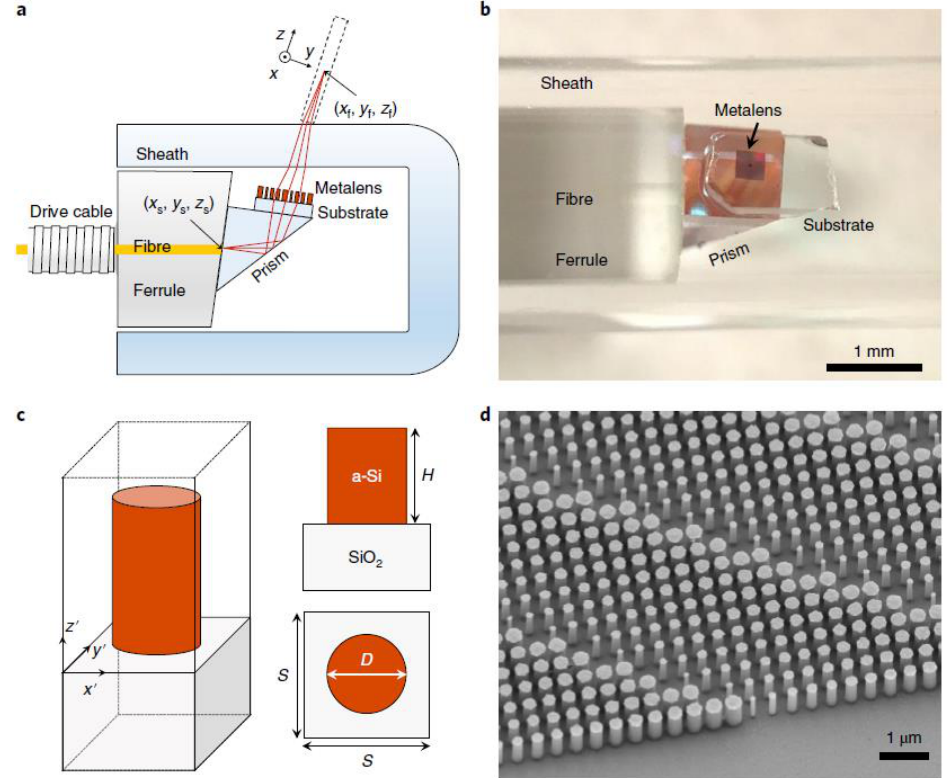
Figure 9. Nano-optic endoscope. ( a ) Schematic of the nano-optic endoscope. ( b ) Photographic image of the distal end of the nano-optic endoscope. ( c ) Schematic of an individual metalens building block consisting of an amorphous silicon (a-Si) nanopillar on a glass substrate. ( d ) Scanning electron micrograph image of a portion of a fabricated metalens. Reproduced with permission from [65].